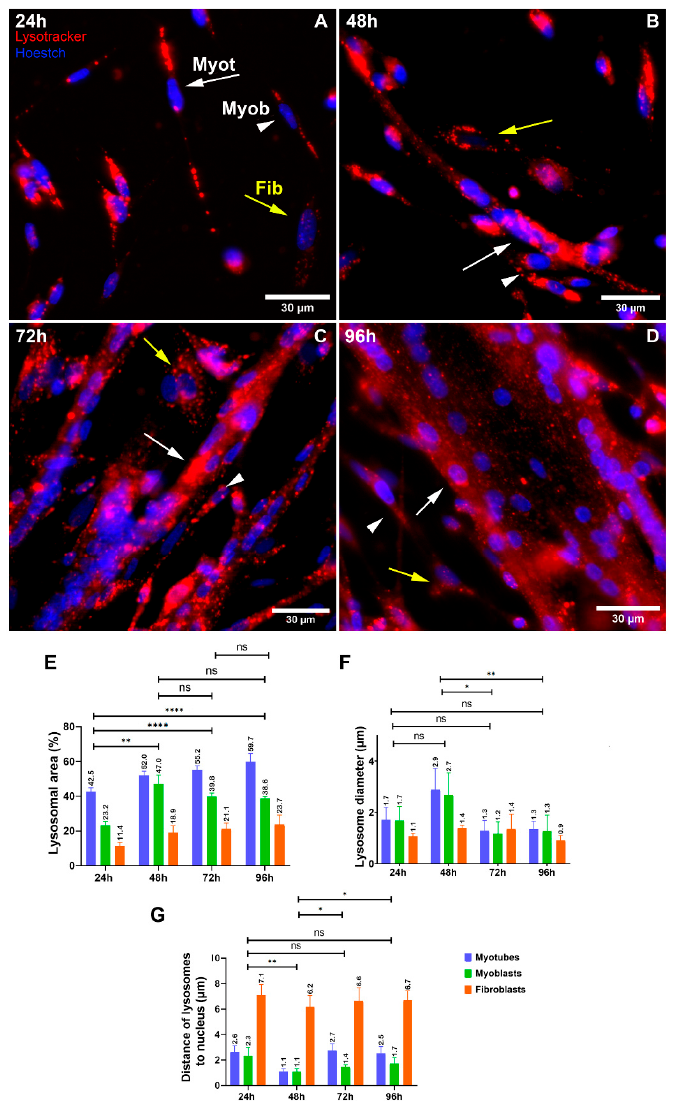
Figure 1. Lysosomal distribution and size differ between muscle and non-muscle cells. Chick myo- genic cells were grown for 24, 48, 72, and 96 h and labeled with Lysotracker and Hoechst ( A – D ). White arrows represent myotubes (Myot), white arrowheads represent myoblasts (Myob), and yel- low arrows represent fibroblasts (Fib). Scale bars in ( A – D ) = 30 μ m. The area and diameter of lyso- somes, and the distance of lysosomes to the nucleus, were quantified from at least fifty randomly chosen microscopic fields collected from three independent experiments. One-way ANOVA fol- lowed by Tukey’s multiple comparison test, * p < 0.05, ** p < 0.01, **** p < 0.0001. Error bars denote mean ± SEM. n.s. = non-significant.